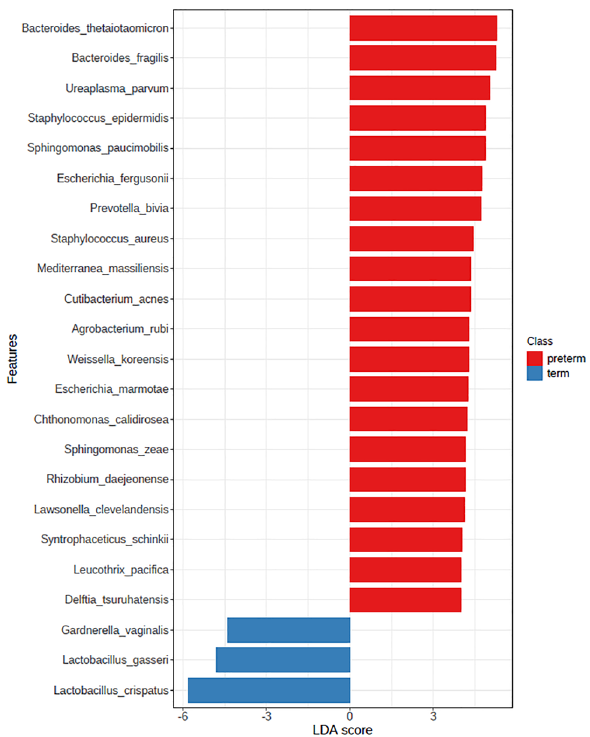
Figure 3. Differential dominant relative abundance of bacterial taxa in the PTB and TB groups. Linear discriminant analysis effect size analysis (LDA score > 4). LDA Linear discriminant